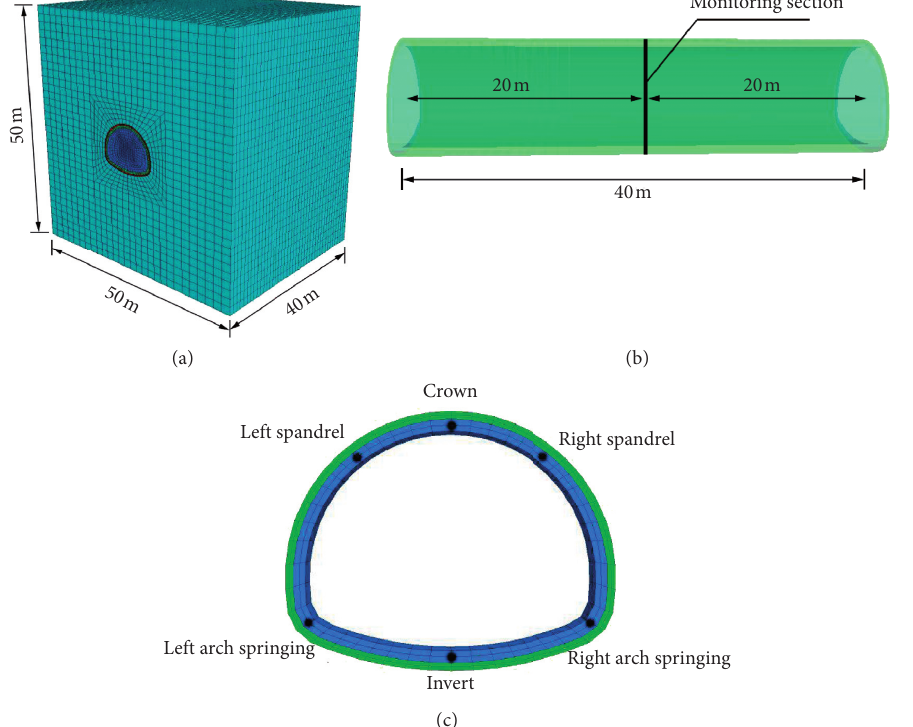
Figure 2: Calculation model of numerical simulation. (a) Overall model. (b) Monitoring section. (c) Monitoring points. Table 1: Physical and mechanical parameters of surrounding rock, initial support, and lining structure. Material